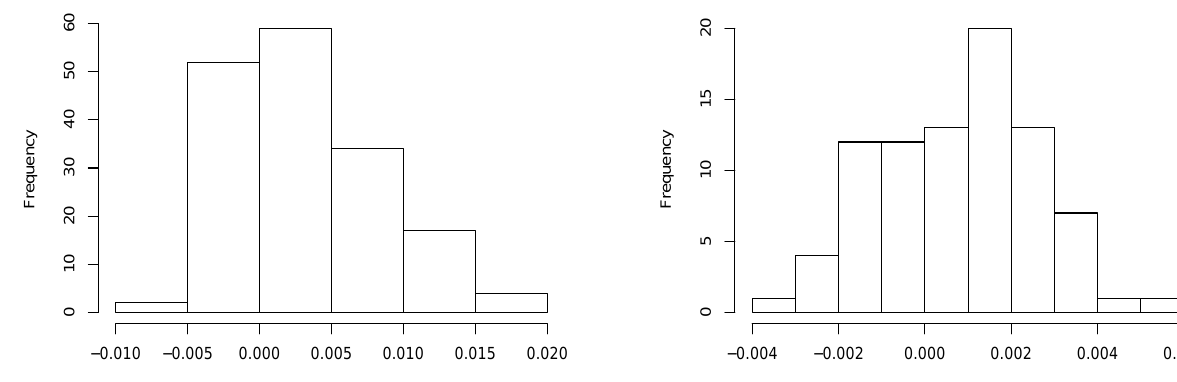
Figure 11. Multi-asset portfolios. This figure shows the marginal contribution of spillover estimates to the key ingredients for portfolio construction using simulated 20-asset portfolios. The graphs illustrate that the marginal contribution is